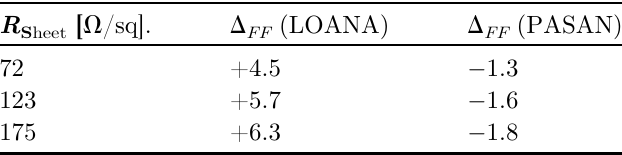
Fig. 8. Measured FF of 3 cells with different TCO sheet resistance for two different setups (blue: 12 wires, rel. sense position =0.2; green: 30 wires, rel. sense position =0.35). In (a) the directly measured values are shown. In (b) the FF of the same measurement setup and cells but with corrected values for the misplaced voltage sense contact is plotted. Table 1. Correction values for the FF to compensate for the non-ideal position of the voltage sense contact for the two used contacting